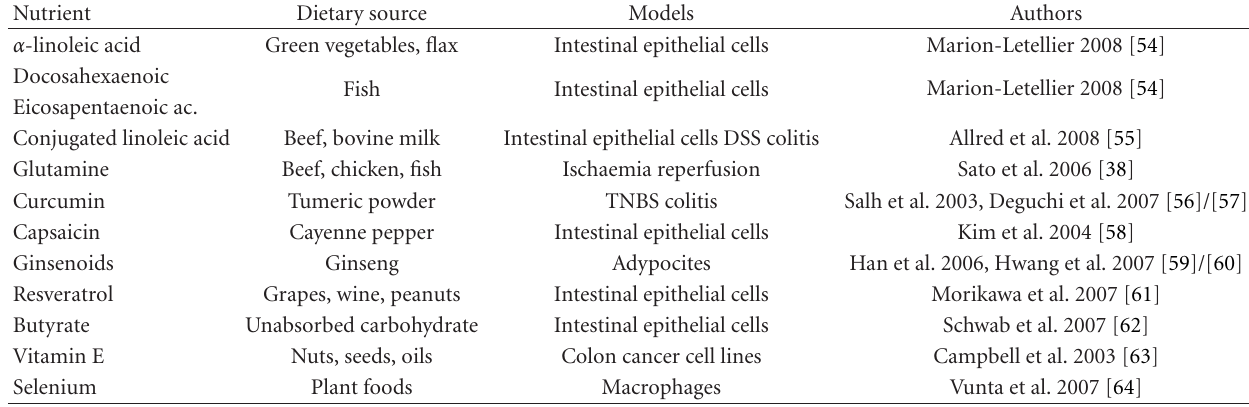
Table 2: Nutrients with demonstrated anti-inflammatory e ff ects mediated through PPAR γ .